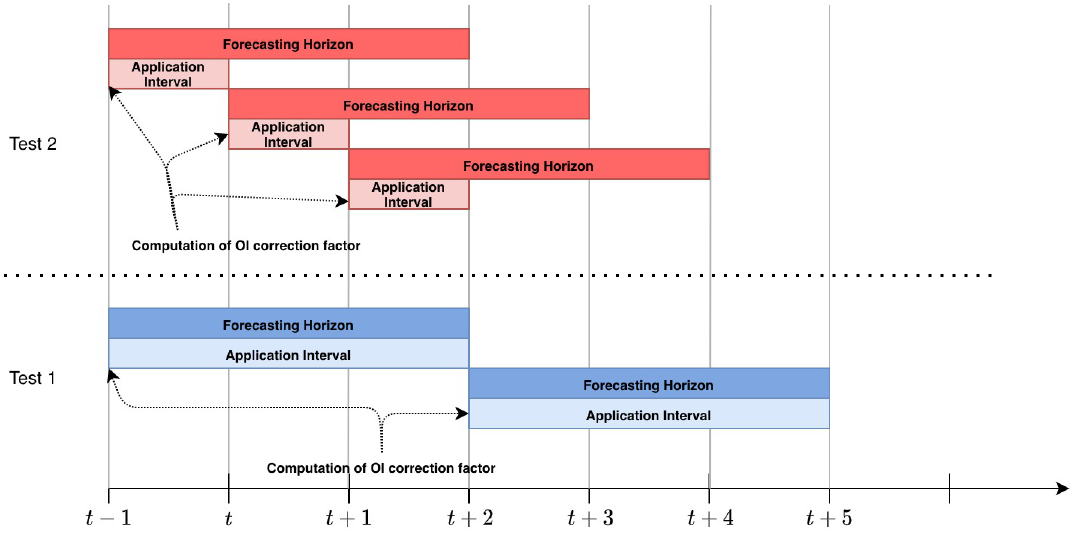
Figure 5. Differences between Test 1 and Test 2